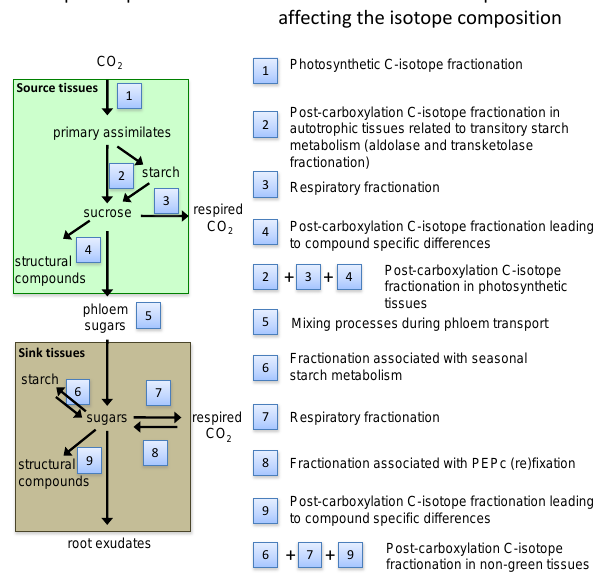
Fig. 1. Summary of the plant-related processes that potentially in- fluence the carbon isotopic composition of organic matter and CO 2 . Carbon isotope fractionation and other processes (i.e. mixing of pools), which influence the isotope composition are listed on the right side of the figure. In addition to the listed fractionation pro- cesses, the carbon isotope composition of atmospheric CO 2 influ- ences δ 13 C of organic matter. The figure is adapted from Gessler et al.